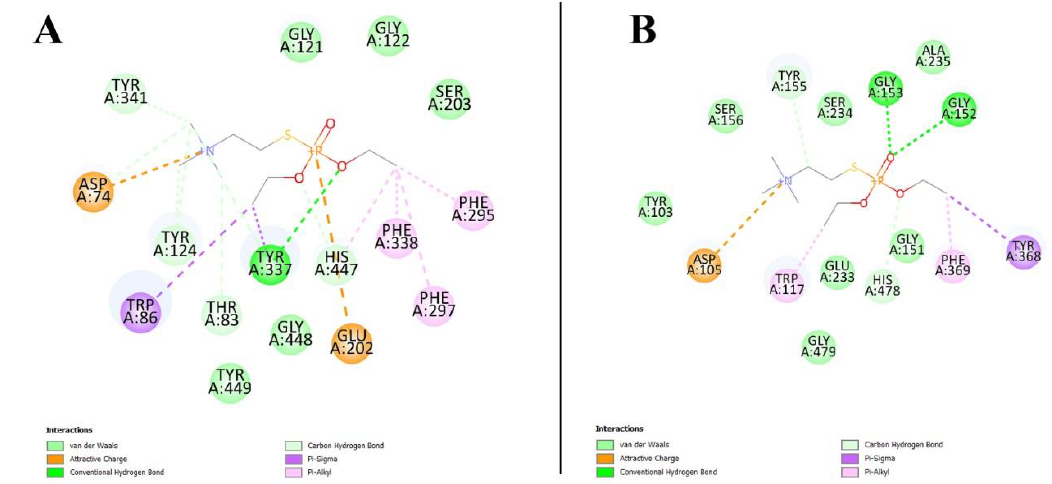
Figure 9. A 2D representation of the protein–ligand complex formed in the active-site gorge between AChE and echothiophate. ( A ) The interactions in hAChE with strong interactions between the ligand and the characteristic tryptophan residue. ( B ) The interactions in rAChE showing tryptophan residues involved in forming the stable protein – ligand complex.